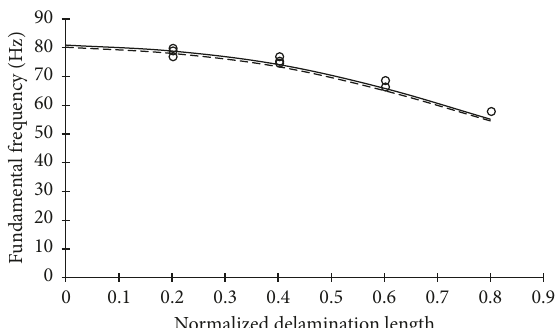
Figure 3: Effect of central midplane delamination on the funda- mental natural frequency of an unstressed cantilevered [0/90] 2s T300/934 graphite/epoxy beam, ── , present model; - - -, analytical [13]; and , experiment [7]. ○